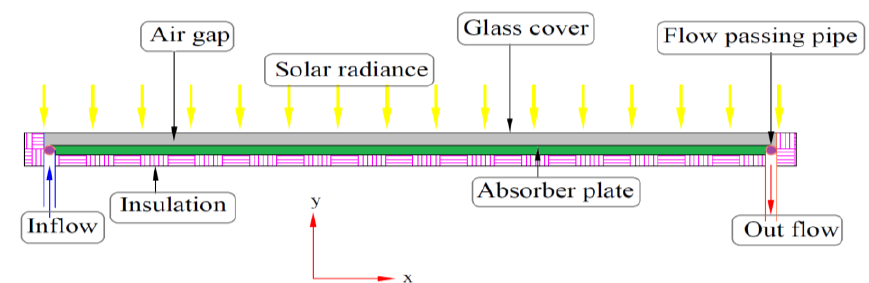
Fig. 5. Schematic diagram of solar collector for forced convection analysis [97].